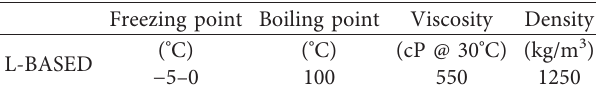
Figure 4: Stabilization mechanism for aggregates with lignosul- fonate [31]. Table 3: Main physical properties and water contained in ligno- sulfonate (from technical